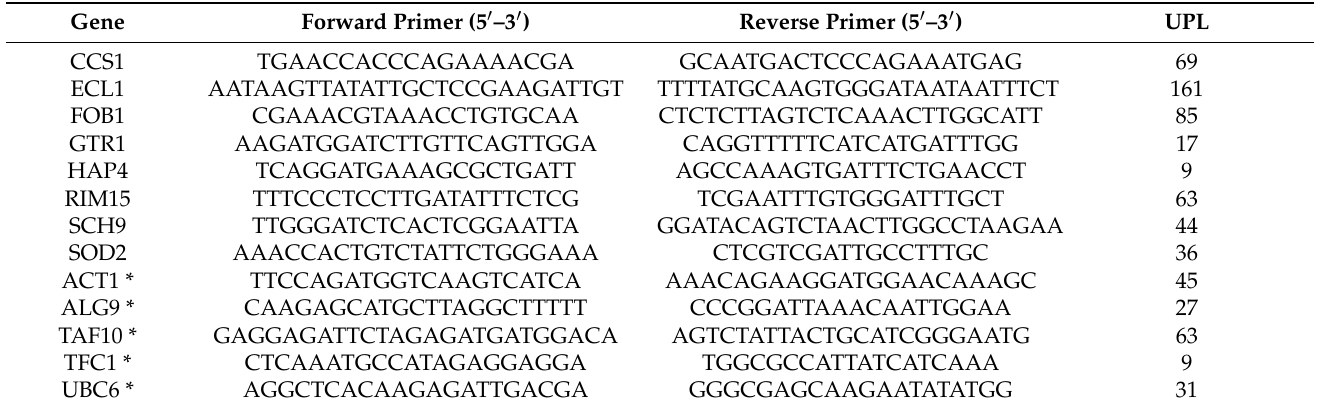
Table 1. Primer sequences used in the qPCR